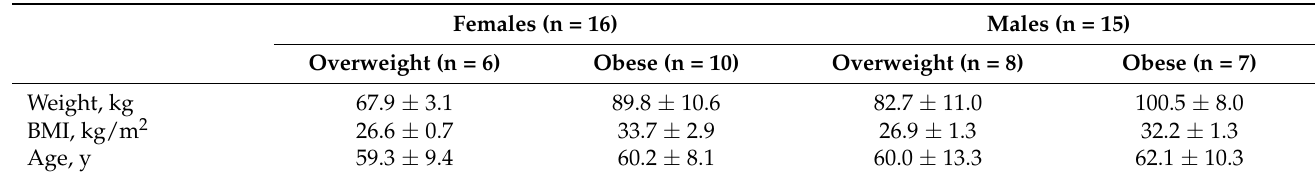
Figure 1. CONSORT (Consolidated Standards of Reporting Trails) diagram for cellular respiration study. Table 2. Subject characteristics at baseline 1